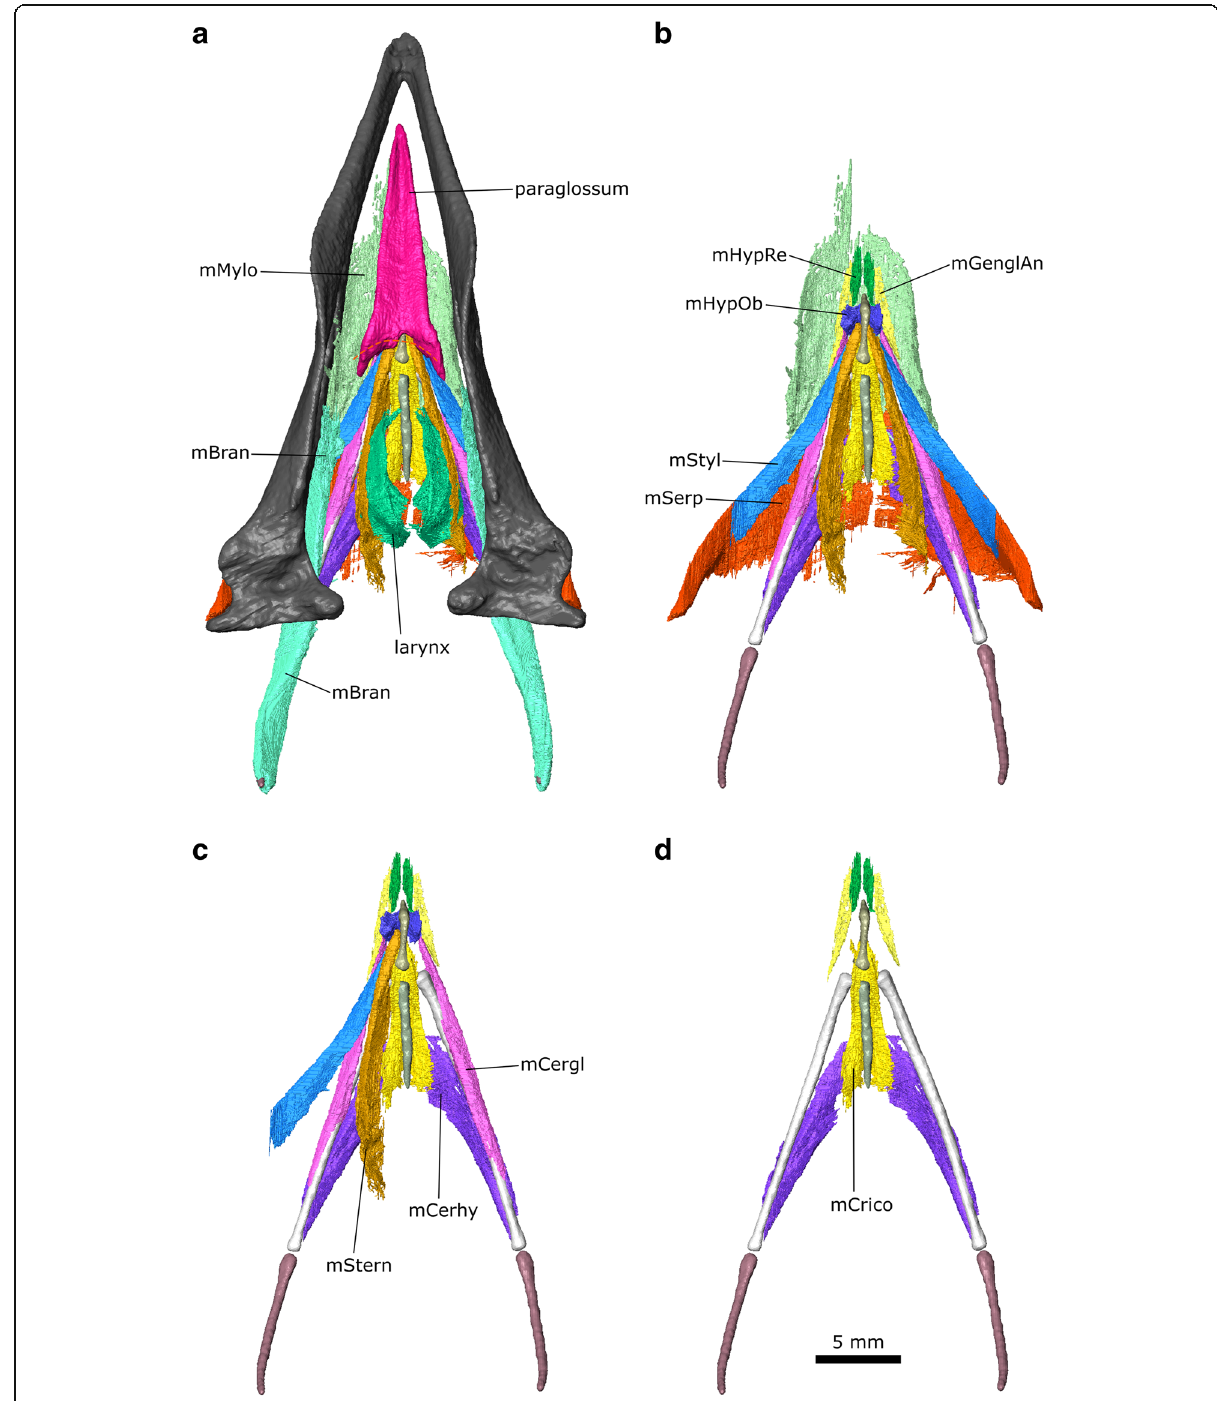
Fig. 13 The throat muscles of Columba livia in dorsal view. a to d represent increasingly deep